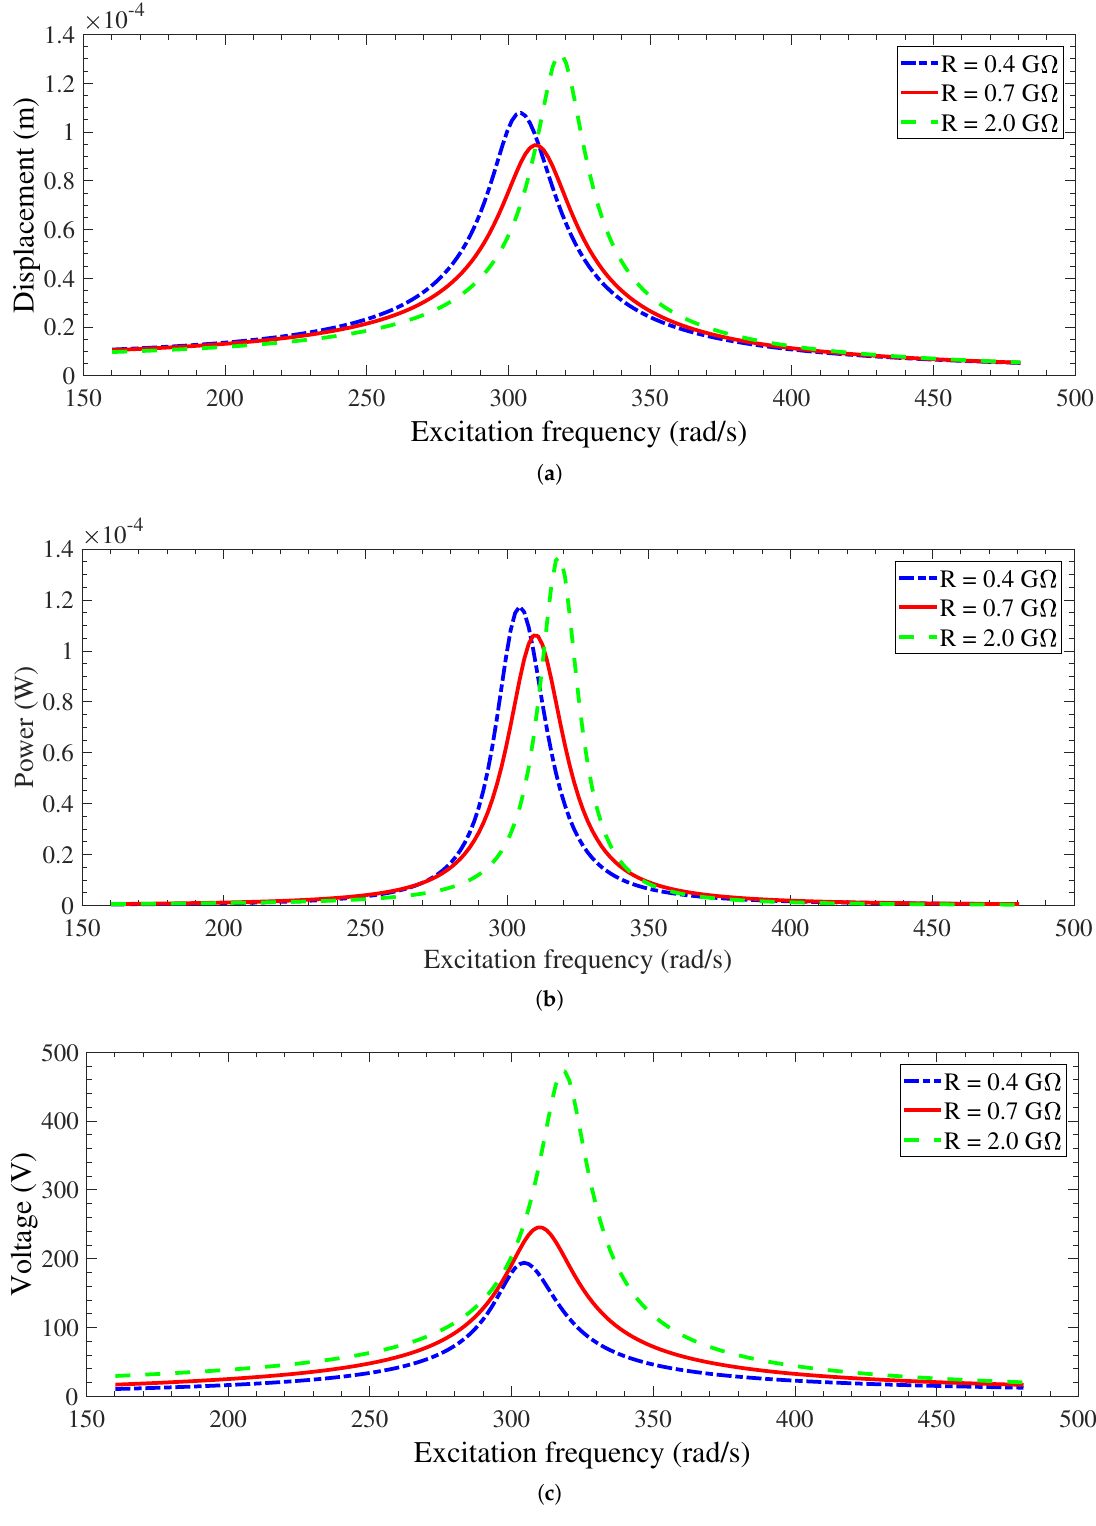
Figure 9. Frequency–response curves in terms of ( a ) displacement, ( b ) electrical harvested power, and ( c ) generated voltage for V et = 2400